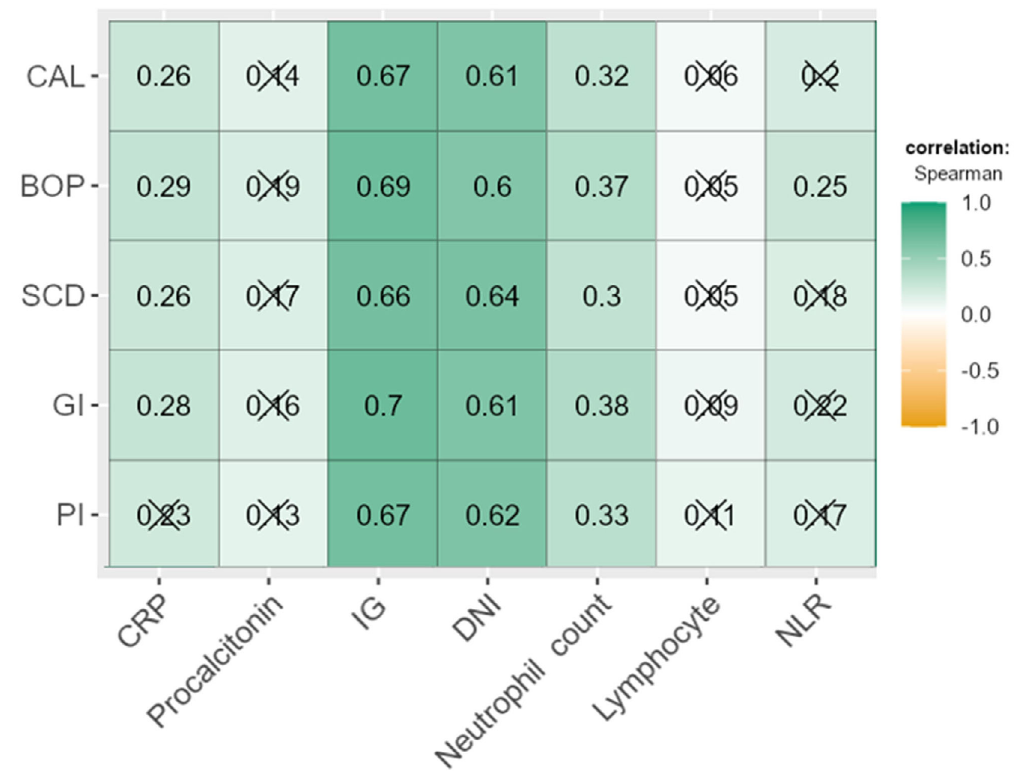
Correlation matrix boxes: green and orange boxes indicate positive and negative correlations, respectively (Colors tones indicate the strength of the correlation). Boxes without “X” indicate significance (p<0.05). Numbers on the boxes are spearmen correlation coefficients. Figure 2- Evaluation of the relationship between periodontitis and hematological parameters by correlation analysis